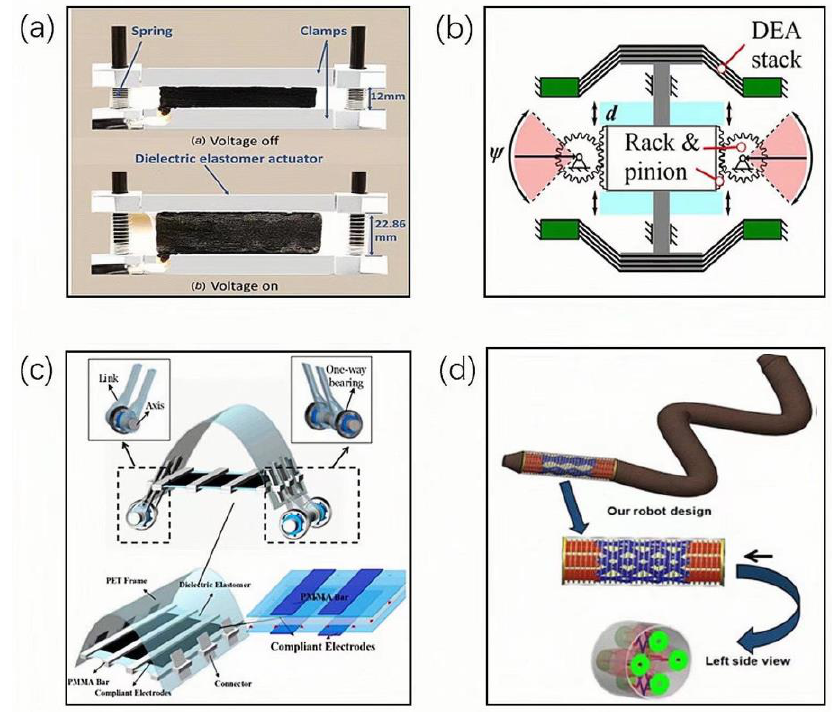
Figure 4. ( a ) DEAs for soft planes [45]. ( b ) Schematic diagram of DCDEA-driven FWM design [46]. ( c ) The design of the soft robot with a unidirectional DEA [48]. ( d ) an earthworm-like soft robot [51].